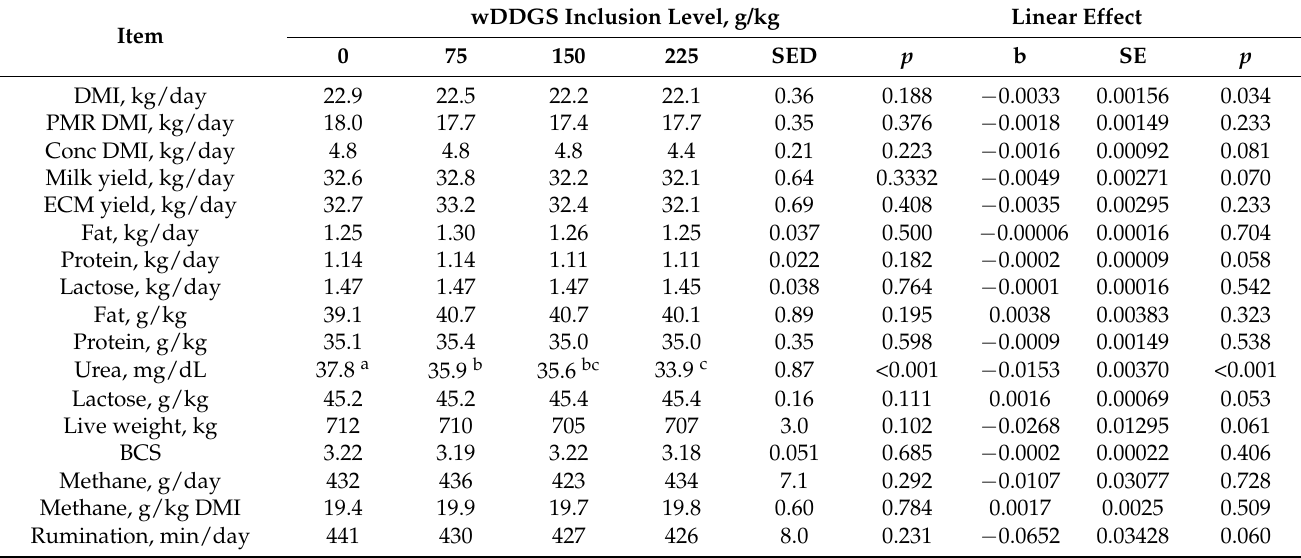
Table 5. (Experiment 2) Mean feed intake and performance of cows when fed on diets containing 0 to 225 g wDDGS DM/kg diet